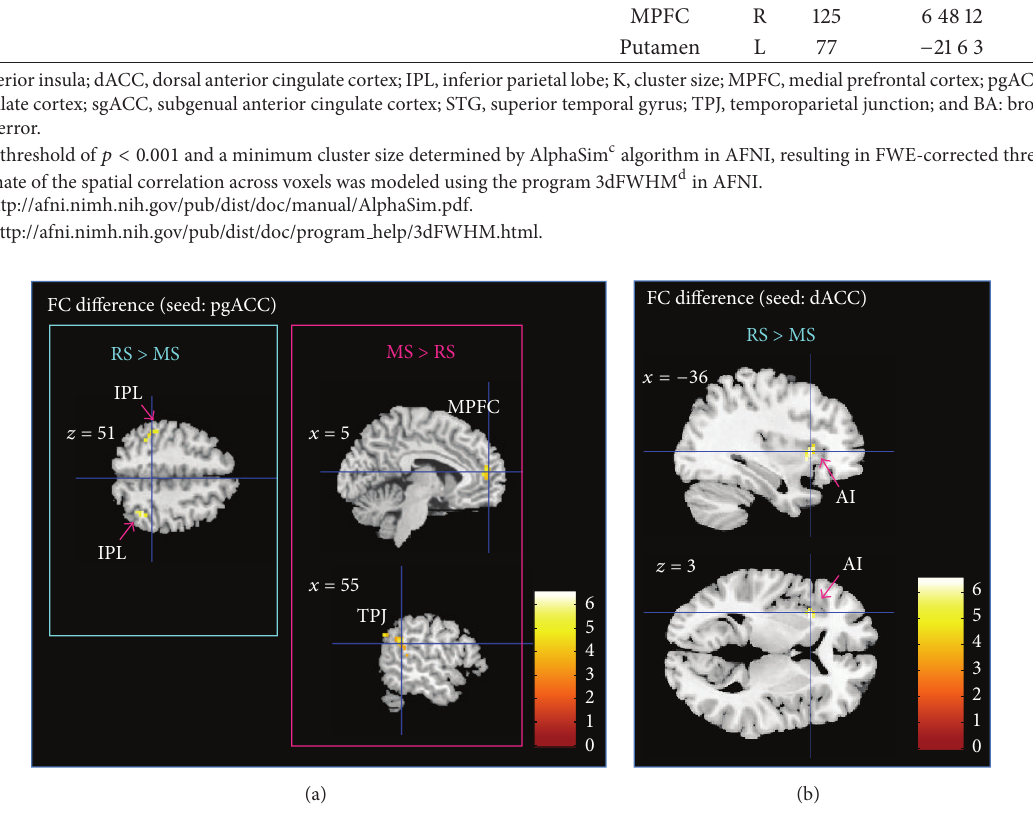
Figure 2: (a) Paired comparison of seed-based FC maps (seed = pgACC) between rest and meditation at TP2 ( 𝑝 < 0.05 , FWE-corrected). Bar plot represents the 𝑡 -values. White labels indicate the coordinate of each slice in the MNI frame of reference ( 𝑥, 𝑧 ). (b) Paired comparison of seed-based FC maps (seed = dACC) between rest and meditation at TP2. FC decreases between dorsal ACC and left AI during meditation as compared to rest ( 𝑝 < 0.05 , FWE-corrected). Bar plot represents the 𝑡 -values. White labels indicate the coordinate of each slice in the MNI frame of reference ( 𝑥,𝑧